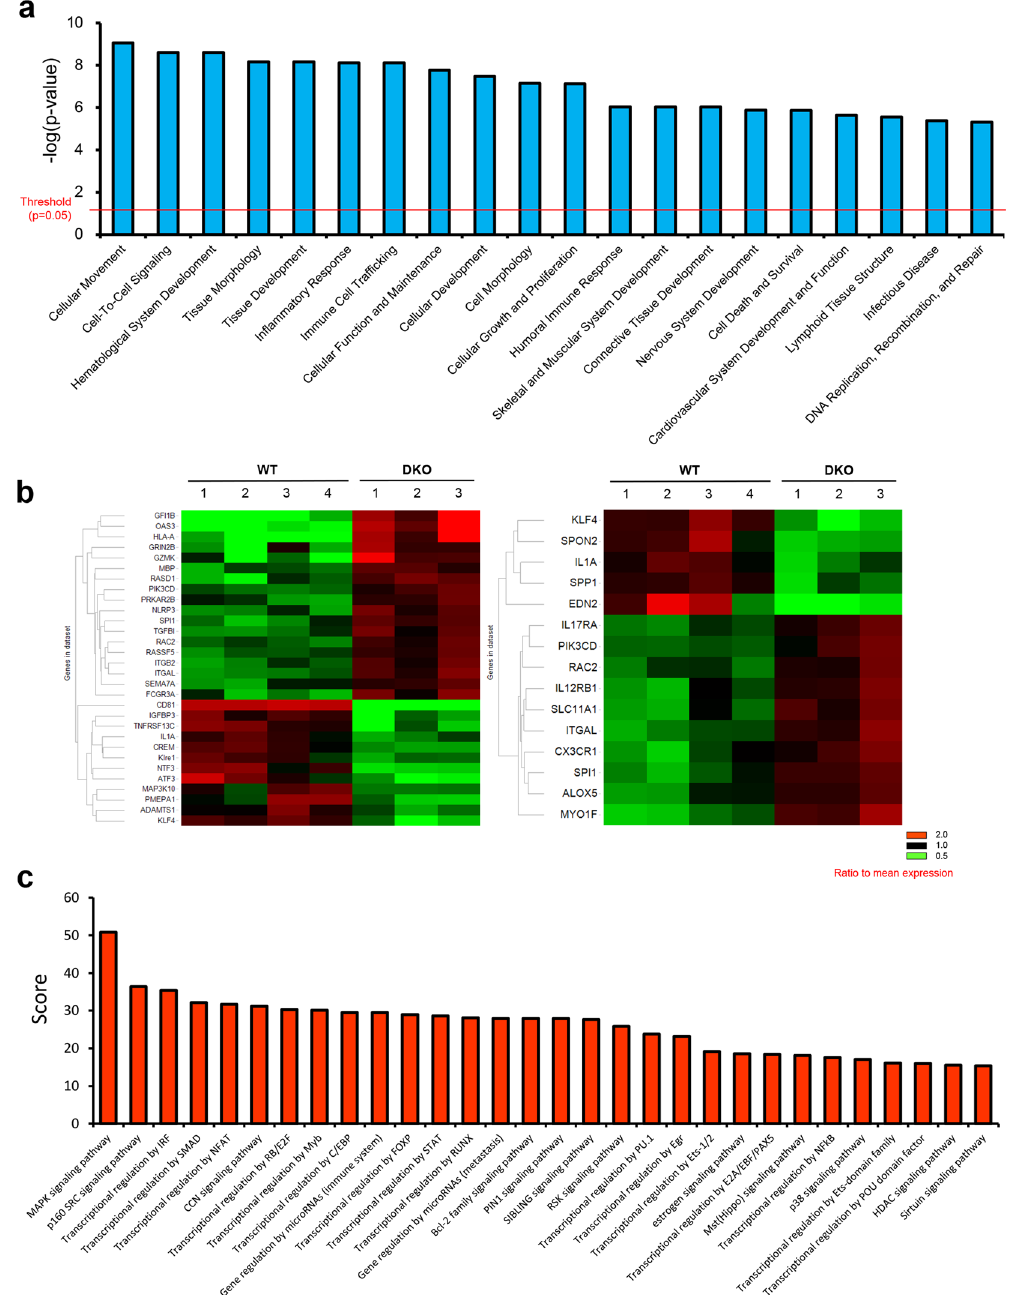
Figure 4. Comprehensive DNA microarray analysis of the lung. ( a ) Differentially expressed genes between WT (n = 4) and CD9/CD81 DKO (n = 3) lungs were analyzed using IPA, and the results shown are the top 20 categories of differentially expressed genes in DKO lungs. (Threshold: P < 0.05) ( b ) Differentially expressed genes in the enriched gene category “cell death” (left) and “inflammatory response” (right) are shown. The heat map indicates that genes promoting cell death or inflammatory response were upregulated in DKO lungs. Red: higher than mean value, Green: lower than mean value. ( c ) Molecular pathways were analyzed using KeyMolnet software. Results shown are the top 30 molecular pathways associated with genes differentially expressed in DKO